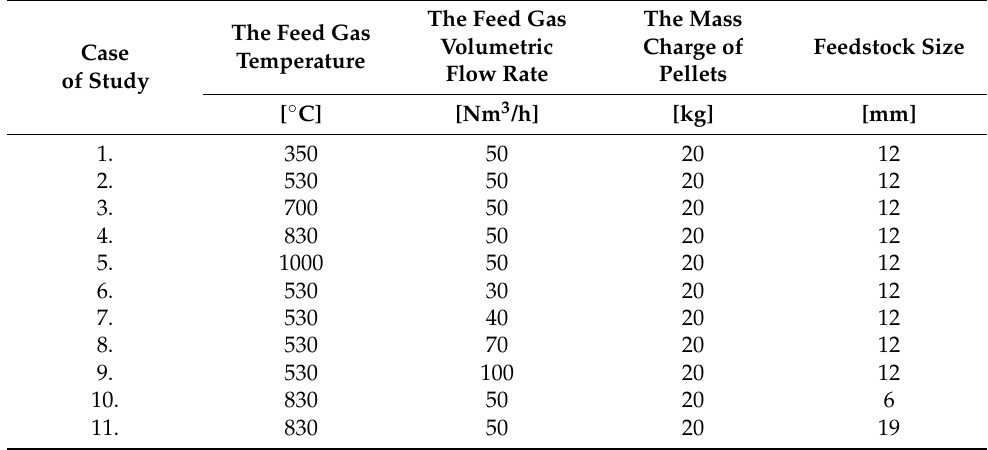
Table 1. The analyzed cases during numerical modeling of a batch flow reactor during pellet